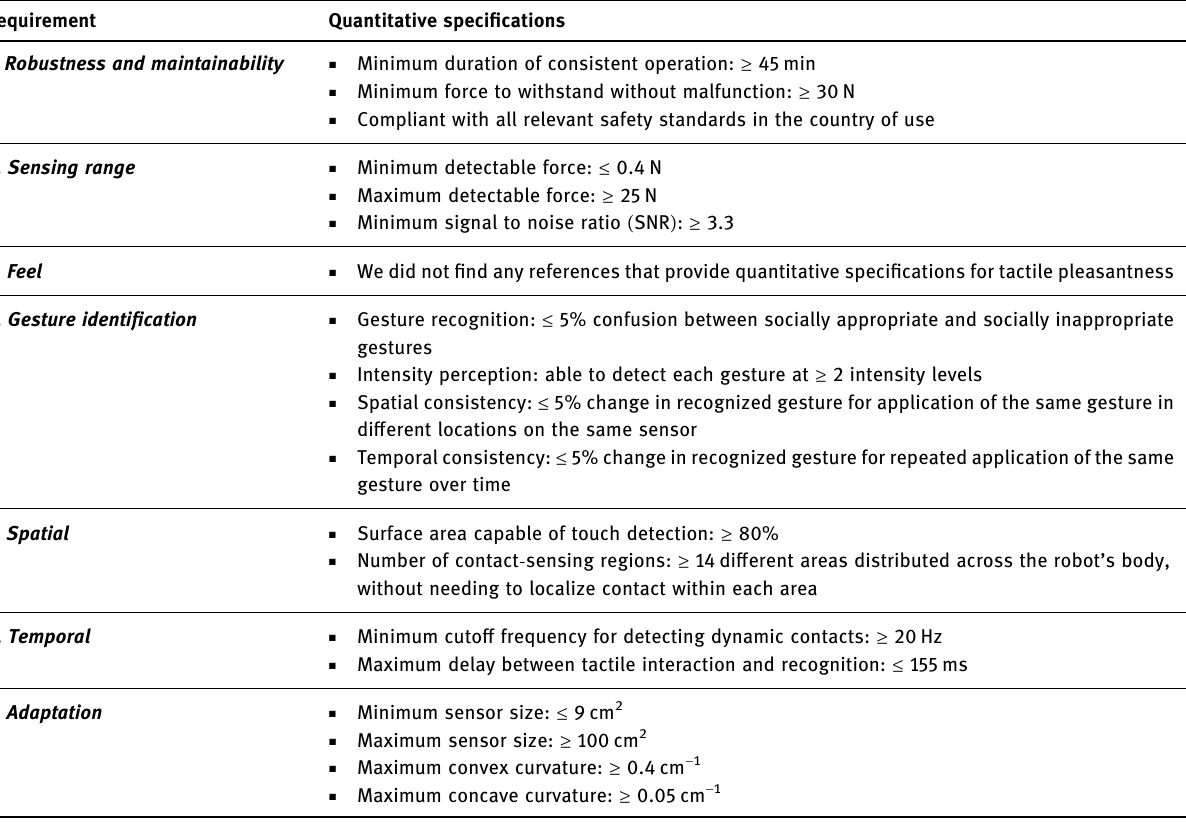
Table 4: The minimum quantitative speci fi cations we propose for a touch - perceiving companion robot for children with autism. These quantitative speci fi cations were translated from our fi nal qualitative requirements ( Table 3 )